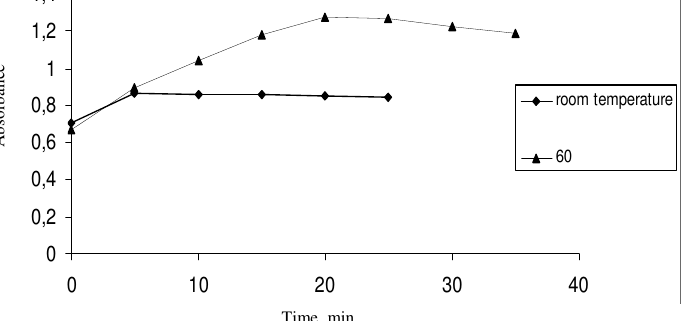
Figure 4. The effect of temperature and time of heating on the reaction between DDQ (at 60 o C) and TCNQ (at room temperature) reagents with DLX at ( ▲ ) DDQ, ( ♦ )